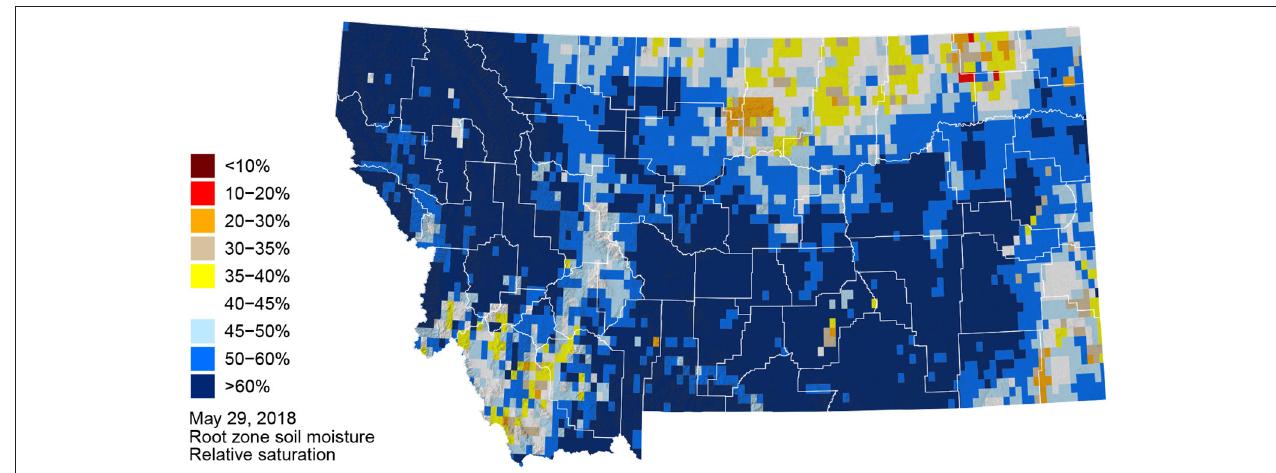
FIGURE 3 | Satellite-derived root zone soil wetness on May 29, 2018. Root zone soil wetness is a measure of how much water has saturated the soil; it is the relative saturation between completely dry and completely saturated soil between 0 and 100cm depth. Soil saturation maps were derived from NASA’s Soil Moisture Active